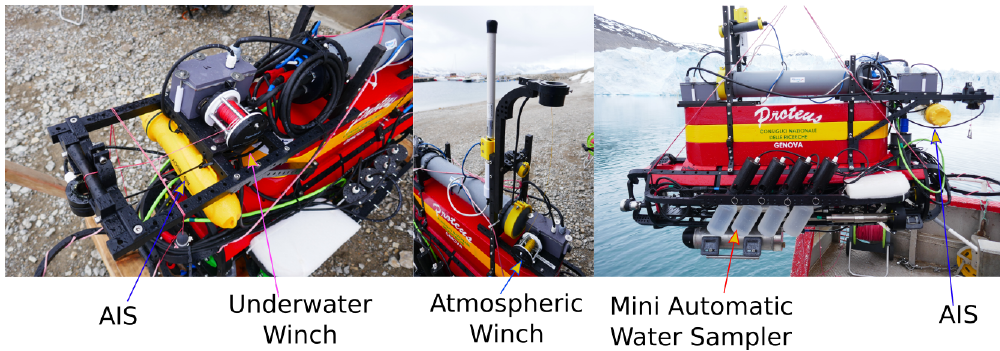
Figure 24. The integration winches and Mini Automatic Water Sampler (MAWS) on-board PROTEUS.